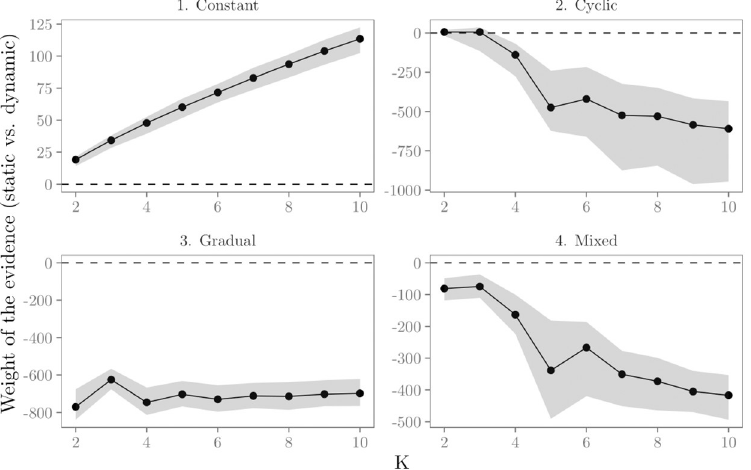
Fig 3. Results for the numerical evaluation of the Bayesian test for time-varying parameters. The y-axis shows the size of the log BF, i.e., the weight of the evidence for the static hypothesis versus the dynamic hypothesis. Black dots and solid lines show per effect scenario the mean log BF with increasing K. The gray area shows the 95% sampling distribution of the log BF.